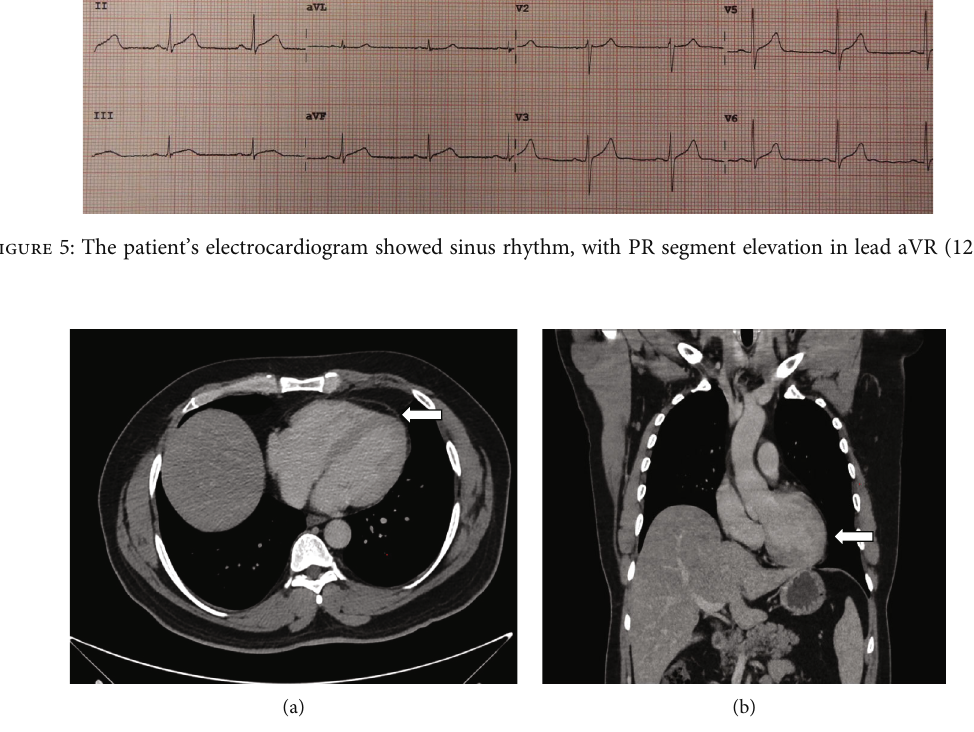
Figure 6: Enhanced CT scan of the chest after a complete course of colchicine and ibuprofen showing improvement of the pericarditis evident by signi fi cant improvement of the pericardial thickening and resolution of the pericardial and left pleural e ff usions.